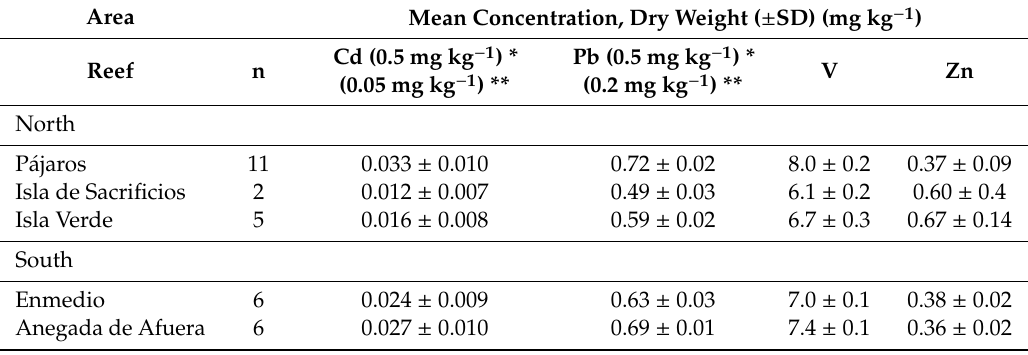
Table 1. Heavy metals detected in muscle of Pterois volitans from Veracruz Reef System National Park (VRSNP),